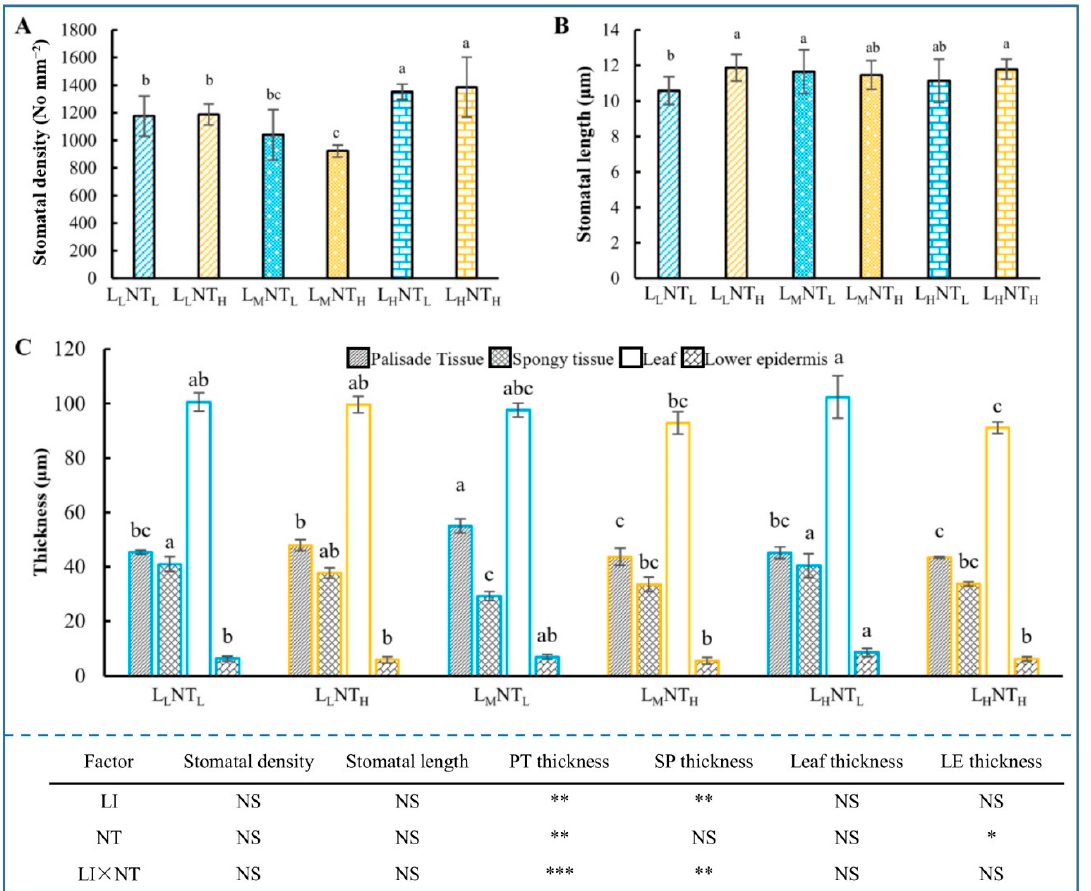
Figure 5. Effect of light intensity (LI) and night temperature (NT) on the stomata traits including stomatal density ( A ) and stomatal length ( B ) and the thickness of different tissues in leaf anatomical structure ( C ) of cherry tomato seedlings. LE, lower epidermis; PT, palisade tissue; SP, spongy tissue. A.; B.; C. Thickness. Abbreviations of different treatments were as described in Figure 1. The symbol “NS”, “*”, “**” and “***” indicate no significance at p < 0.05, significant level at p < 0.05, p < 0.01 and p < 0.001 by Duncan’s test, respectively. Different letters on bars for the same parameter indicate statistically significant differences ( p < 0.05).